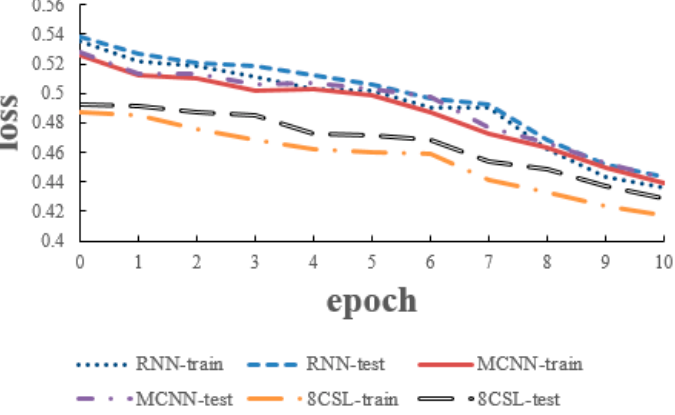
Figure 12. Loss curves of the three models on the 10 second data.